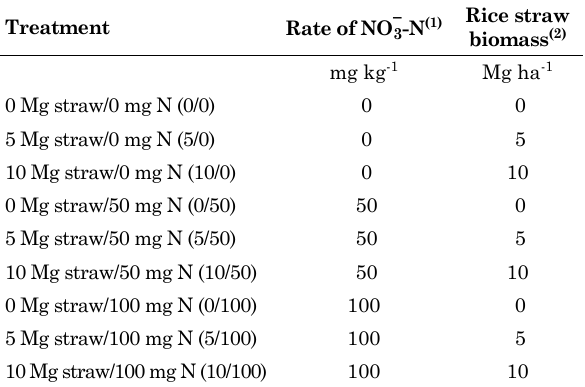
Table 1. Experimental treatments consisting of combination of quantities of rice straw biomass and nitrate rates application